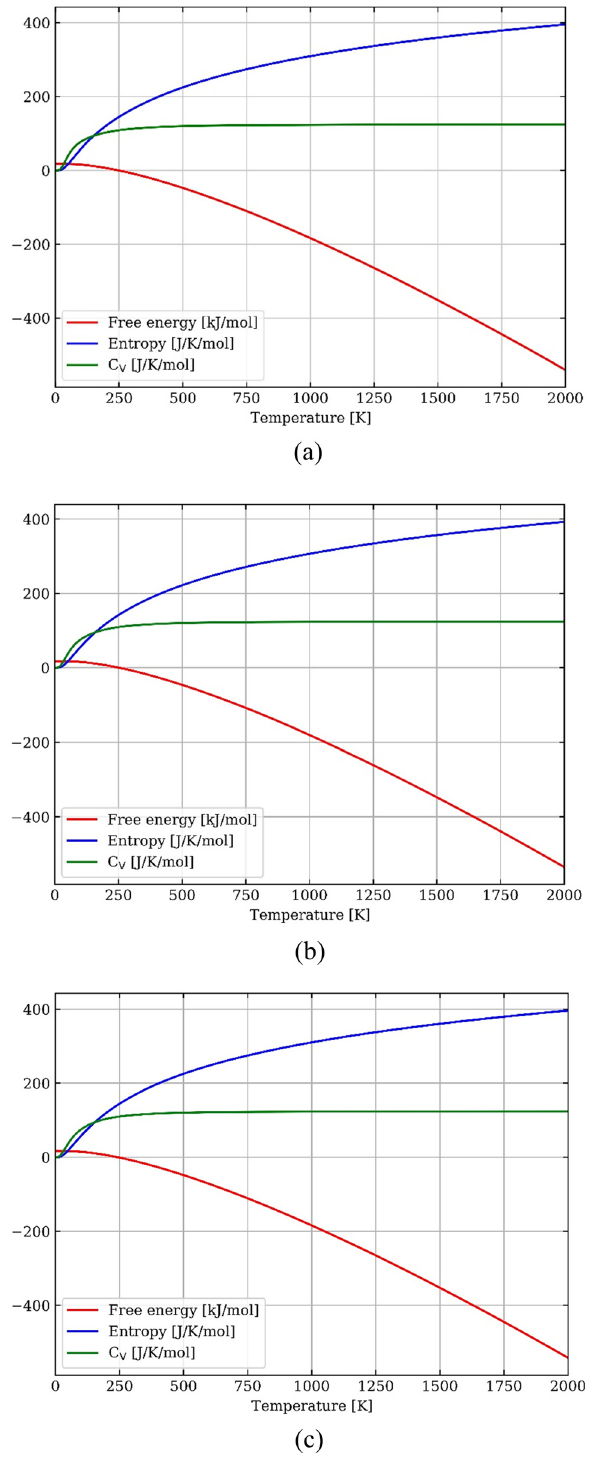
Figure 6: The calculated thermal properties for XInO 3 ( X = K ( a ) , Rb ( b ) , and Cs ( c ))